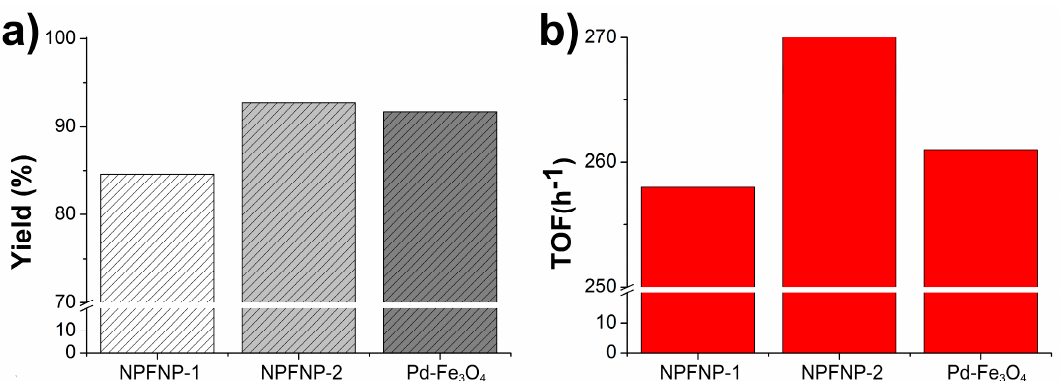
Figure 4. Comparison of ( a ) yield and ( b ) TOF (the value was defined as the number of molecules produced at each mole of Pd of nanoparticles per time) for the products in the Suzuki–Miyaura coupling reaction.